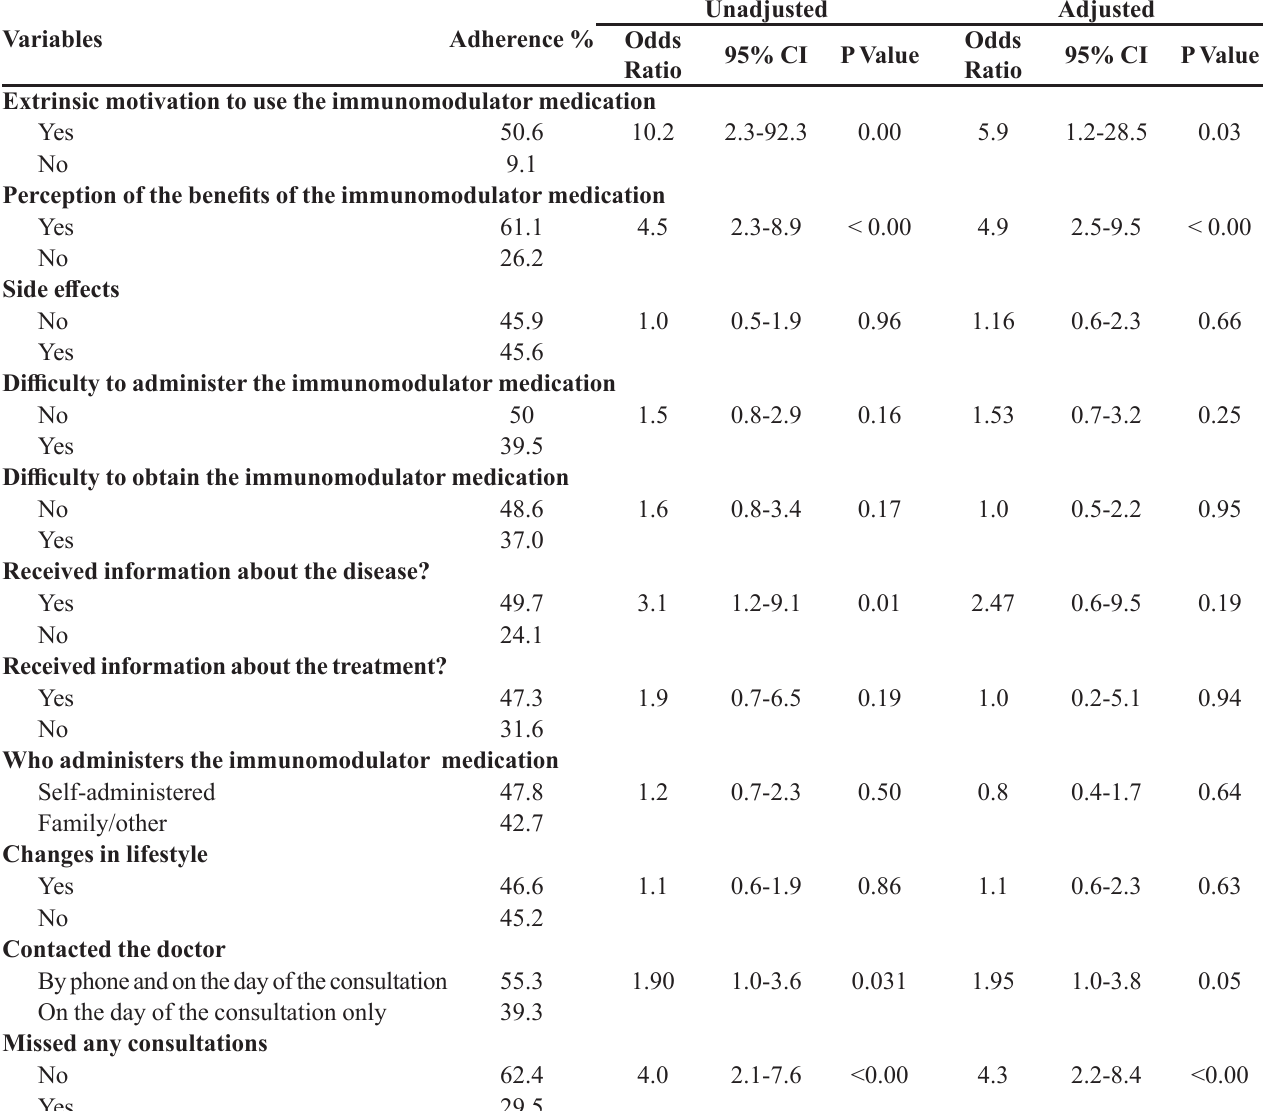
TABLE III – Association between adherence and the variables adjusted in the logistic regression model divided into blocks. Ceará, 2012